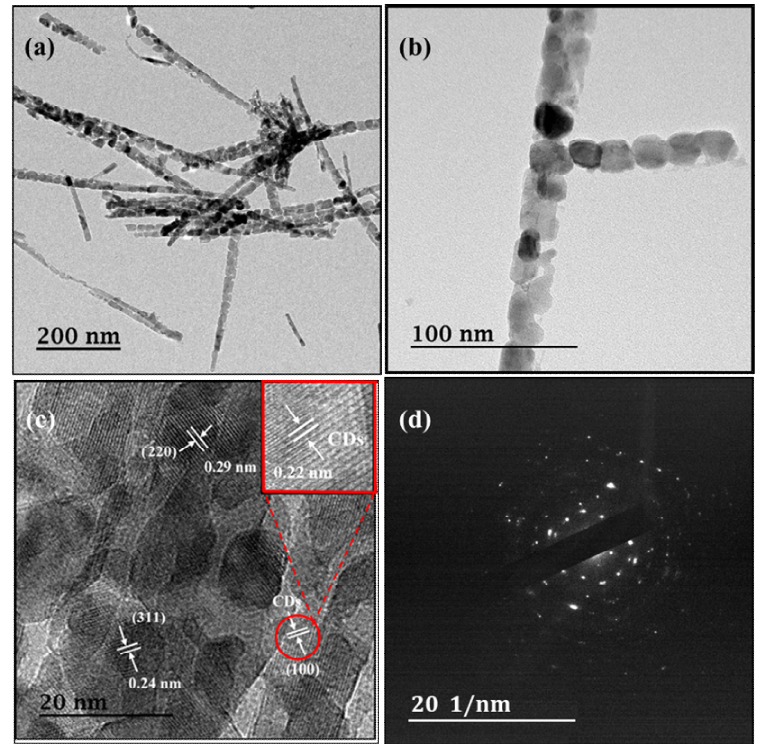
Figure 3. TEM ( a , b ), high-resolution transmission electron microscopy (HRTEM) ( c ) images and ( d ) selected area electron diffraction (SAED) patterns of FCCD25.